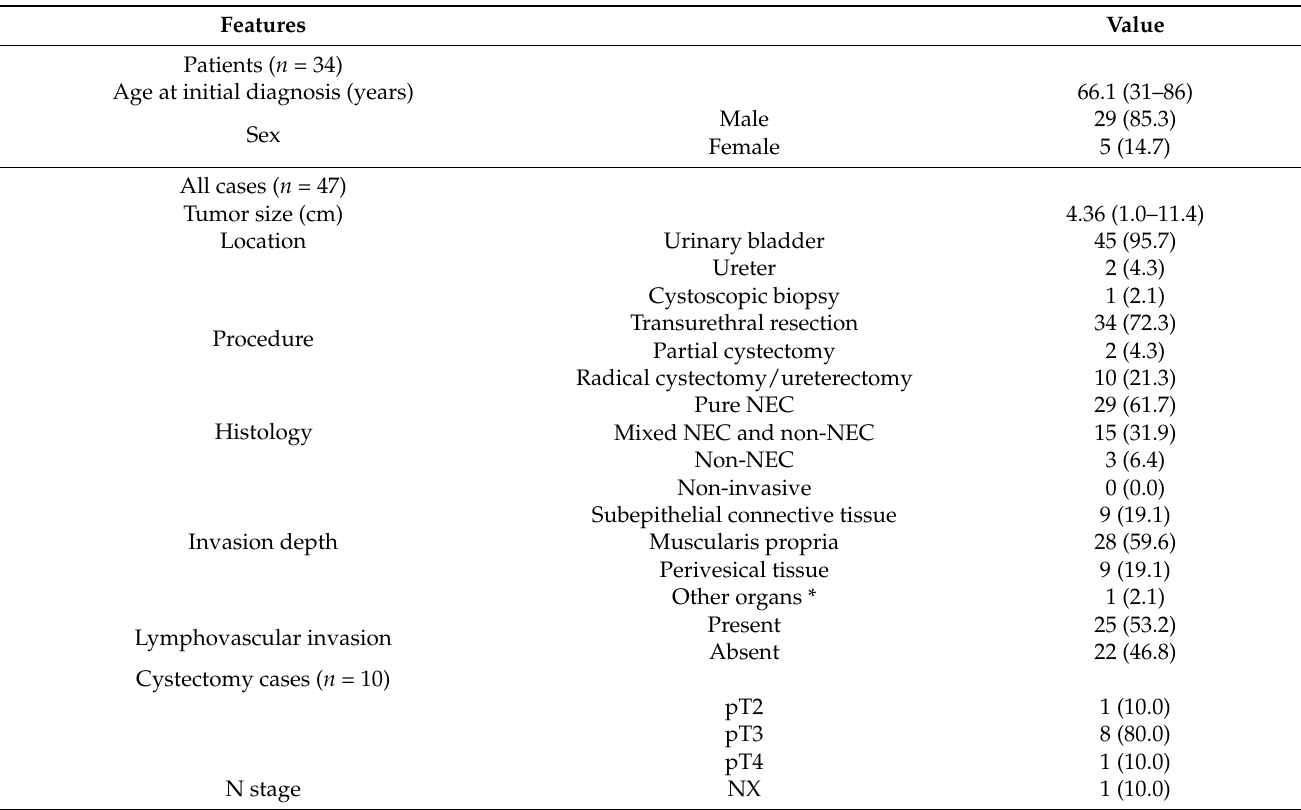
Table 1. Clinicopathological features of the discovery